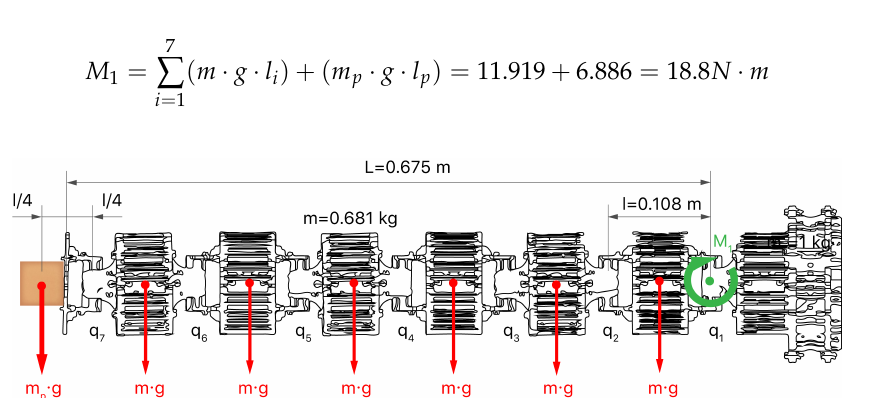
Figure 3. Free body diagram of the required torque exerted by the first joint to balance a payload and the weight of the robot body.